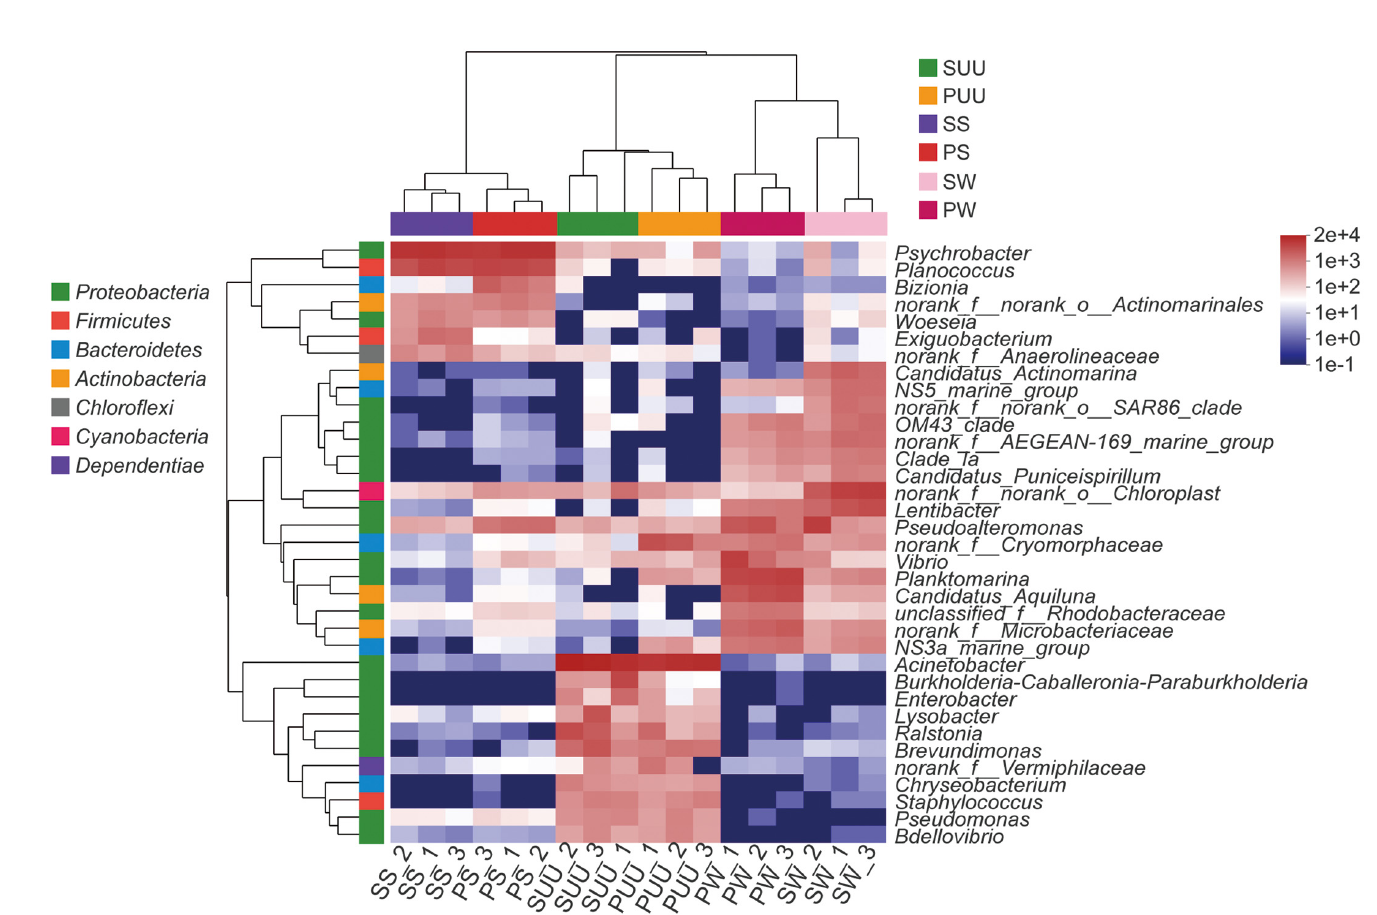
Fig. 2. Hierarchical clustering heat map at the genus level in samples collected from the intestine and habitats of Urechis unicinctus . The top row lists the sample group information (abbreviations as in Table 1). The left vertical column lists the cluster information, and the right vertical column lists the genera annotated by Silva. The heatmap plot depicts the relative abundance of each genus (vertical-axis clustering) within each group (horizontal-axis clustering). The Z -values, based on the abundance of gene sequences after normalization, are indicated by color intensity (legend indicated on the right